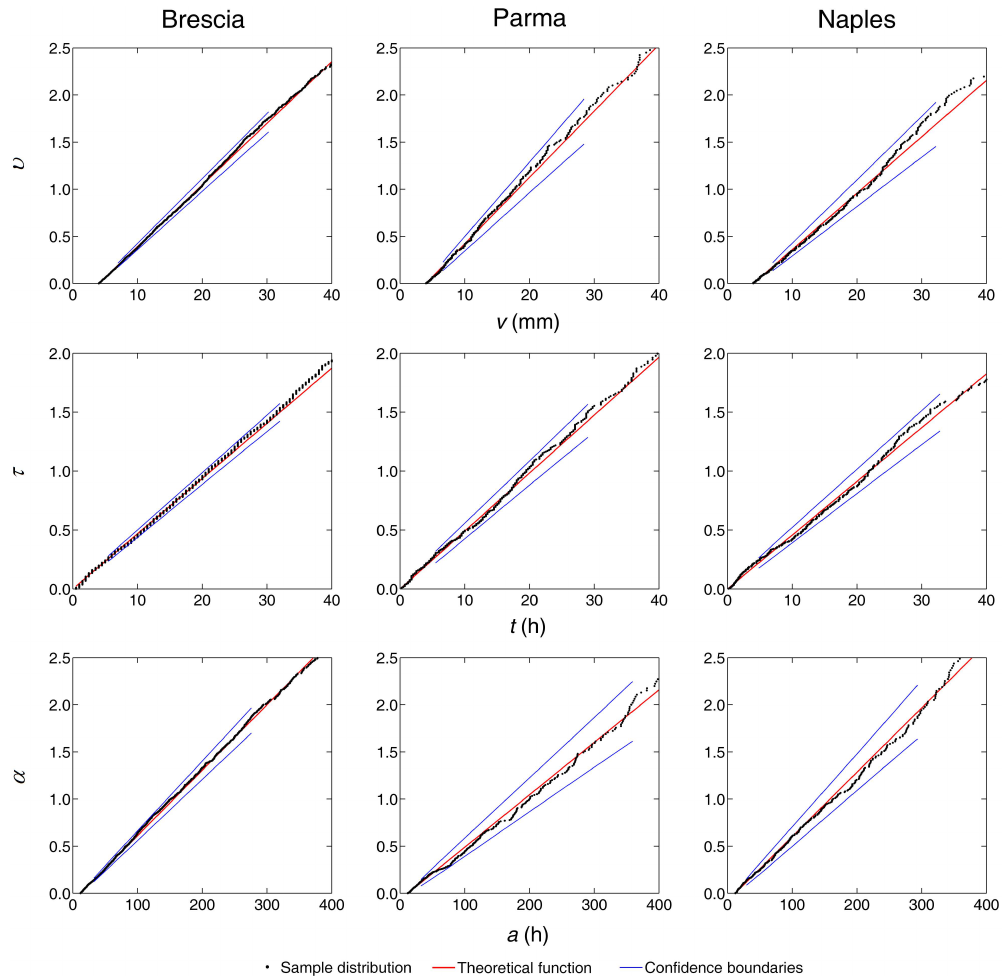
Fig. 6. Margin goodness-of-fit tests for samples extracted by using IETD=12h and IA=4mm.